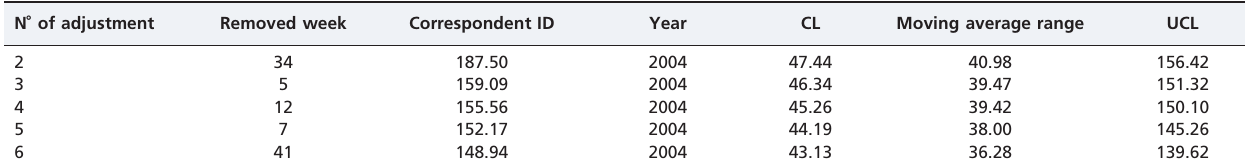
Table 3 - The steps used to find the final control limits.